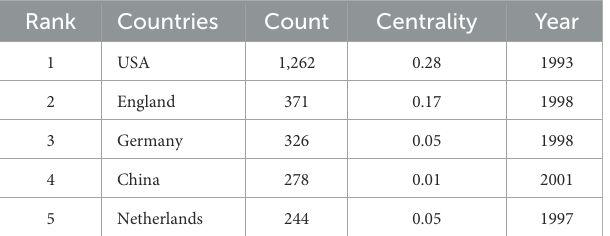
TABLE 1 Top five countries with publications on ADHD neuroimaging from 1992 to